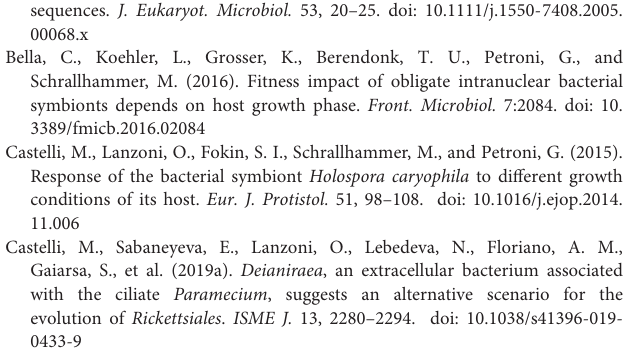
FIGURE S1 | Schematic representation of the procedure followed for the fitness experiment. FIGURE S2 | Species affiliation of LgJac and YE9 based on COX1 sequence analysis. Maximum likelihood tree of the genus Paramecium calculated with IQ − TREE based on an alignment of 34 sequences from 10 different Paramecium species comprising 620 characters. Here obtained sequences are reported in bold. Numbers near nodes indicate Ultrafast Bootstrap support values (below 75% not shown), numbers in brackets indicate sequences in collapsed groups. Scale bar corresponds to 0.1 sequence divergence. FIGURE S3 | Molecular characterization of the endosymbionts of YE9 and LgJac based on 16S rRNA gene sequences. Maximum likelihood tree calculated with IQ − TREE based on 43 sequences belonging to members of the genera “ Ca . Megaira” and Rickettsia comprising 1343 characters. Here obtained sequences are reported in bold. Numbers near nodes indicate Ultrafast Bootstrap support values (below 70% not shown). Scale bar corresponds to 0.01 sequence divergence. Ca . stands for Candidatus . TABLE S1 | Data sheet for fitness analysis. DATA SHEET S1 | R